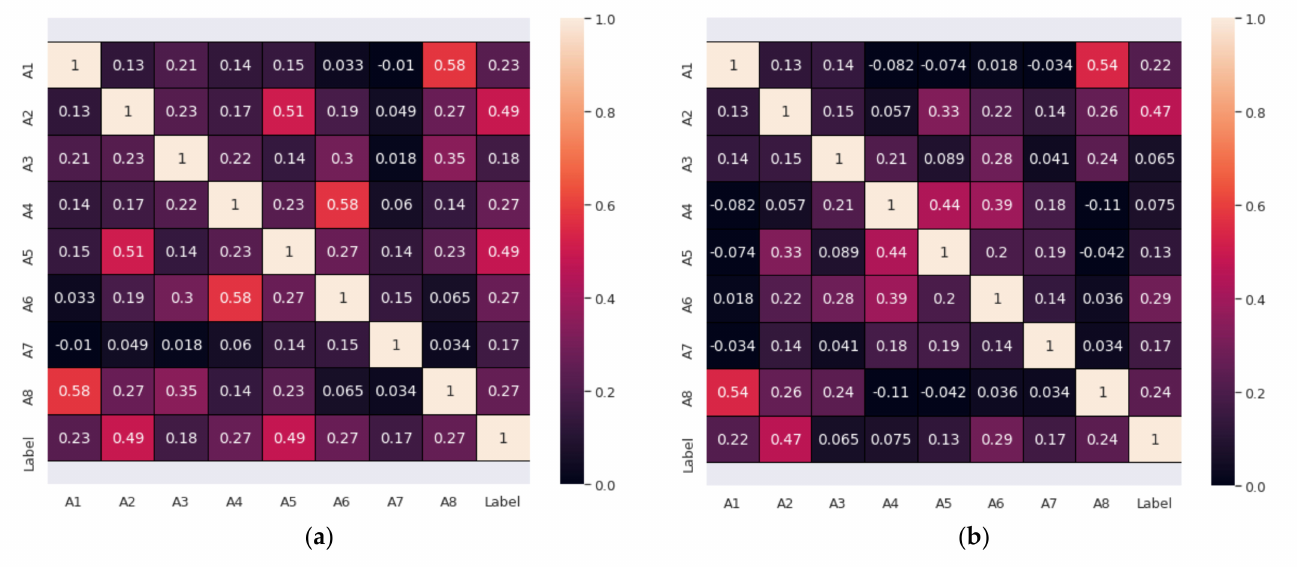
Figure 5. The resulting confusion matrix represents the correlation of features based on PIDD. ( a ) Before processing. ( b ) After